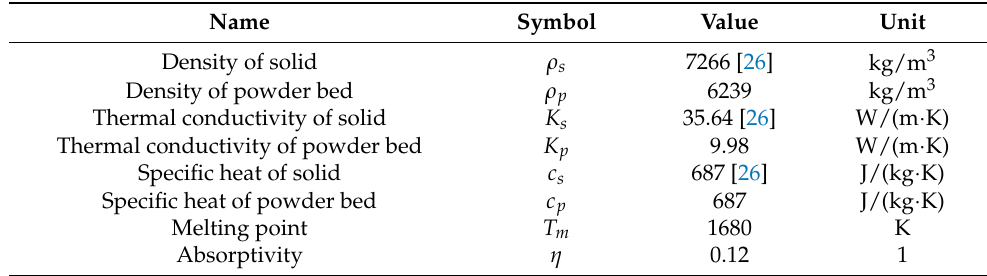
Table 3. Material properties of 316L stainless steel.